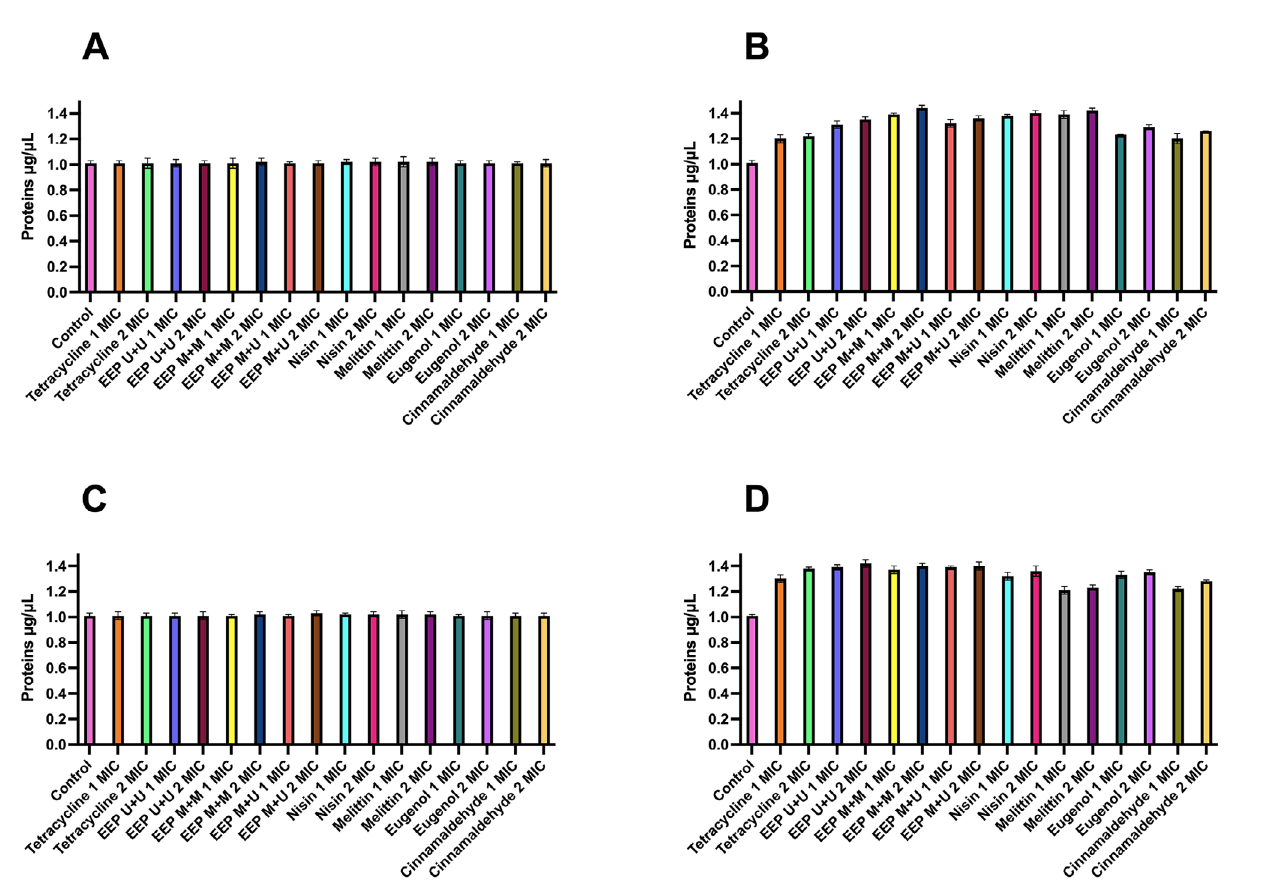
Figure 5. Proteins released in the supernatant (μg/μL) when exposed to concentrations equivalent to 1 and 2 MIC of the different treatments against B. subtilis at times (A) T0 and (B) T4 and against P. alvei at times (C) T0 and (D) T4.